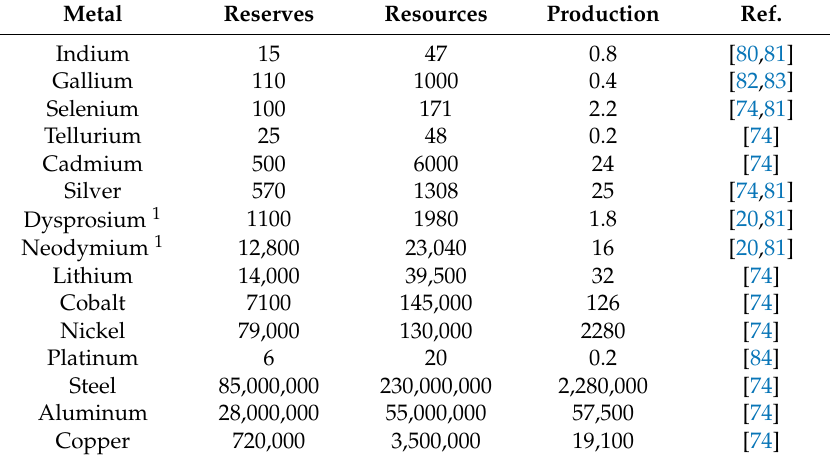
Table 7. Reserves and Resources used in this paper (Unit: